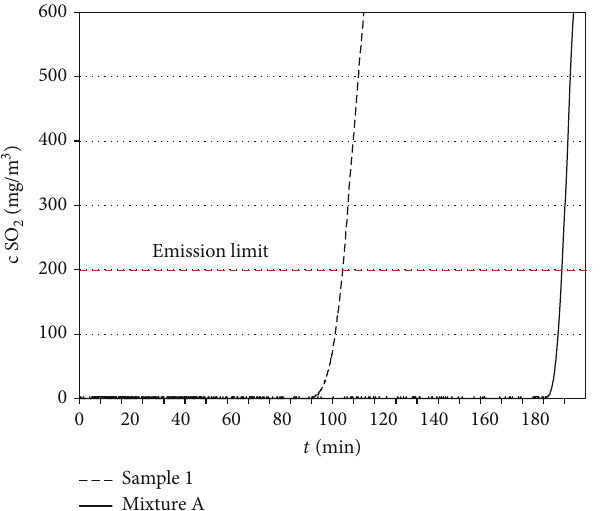
Figure 6: Comparison of mixture A with sample 1.